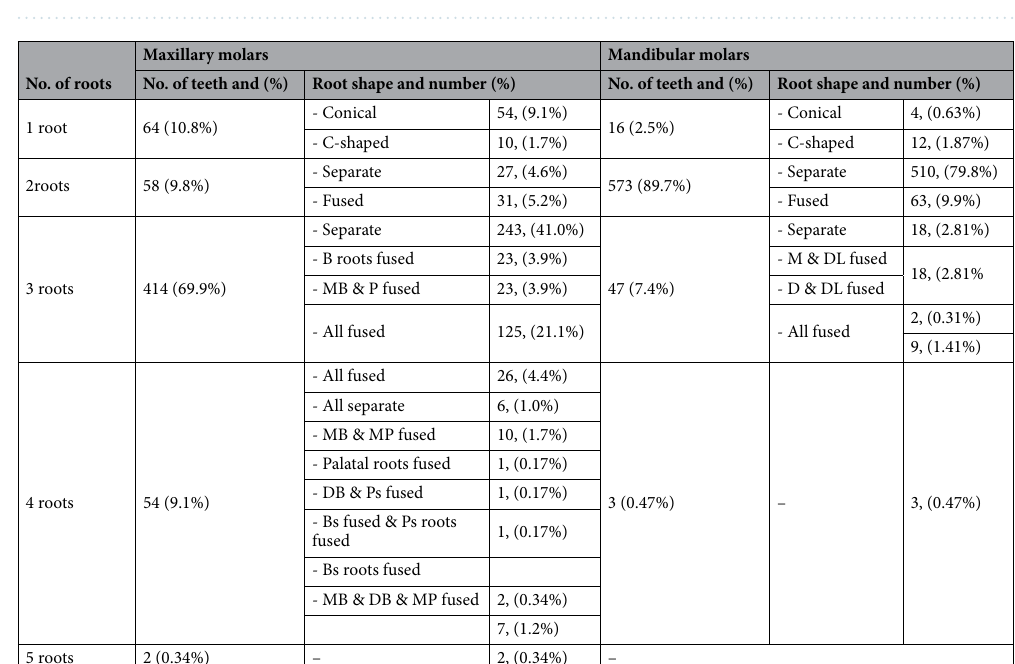
Figure 1. Classification of canal system by Vertucci 19 , and the additional modifications 20 .